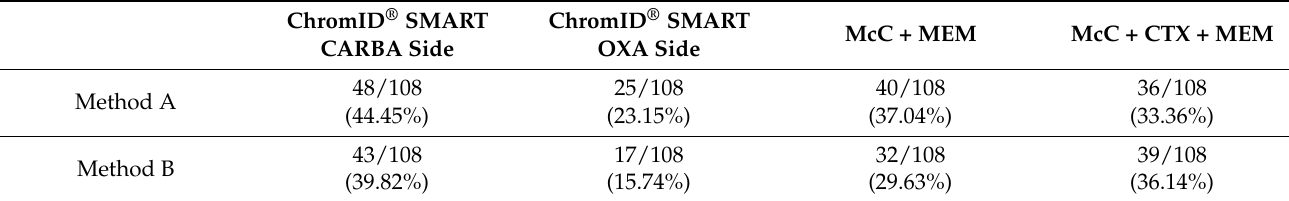
Table 2. Validation of the selective agars by counting the number of plates with growing of accompanying microbiota for each group per used method. McC + CTX + MEM = MacConkey Agar supplemented with 1 mg/L cefotaxim and 0.125 mg/L meropenem; McC + MEM = MacConkey Agar supplemented with 0.125 mg/L meropenem.